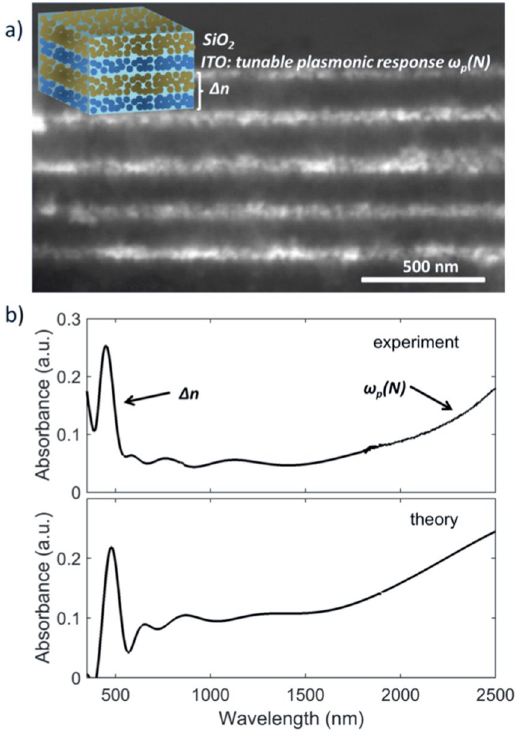
Figure 1. ( a ) SEM cross section of the SiO 2 /ITO 1D photonic crystal. The bright layers correspond to the higher contrast ITO nanoparticle layer, the darker layers to SiO 2 . Inset: sketch of the SiO 2 /ITO 1D photonic crystal indicating the contribution to the optical response: Δ n corresponds to the refractive index contrast, which is responsible for the photonic bandgap in the visible, while the high absorption in the near infrared is due to free carriers (i.e. plasmonic response) of the ITO nanoparticles depicted by the plasma frequency as a function of the carrier density N ( ω p (N) ). ( b ) Experimental (upper panel) and theoretical (lower panel) absorption spectrum of the 1D photonic structure at normal